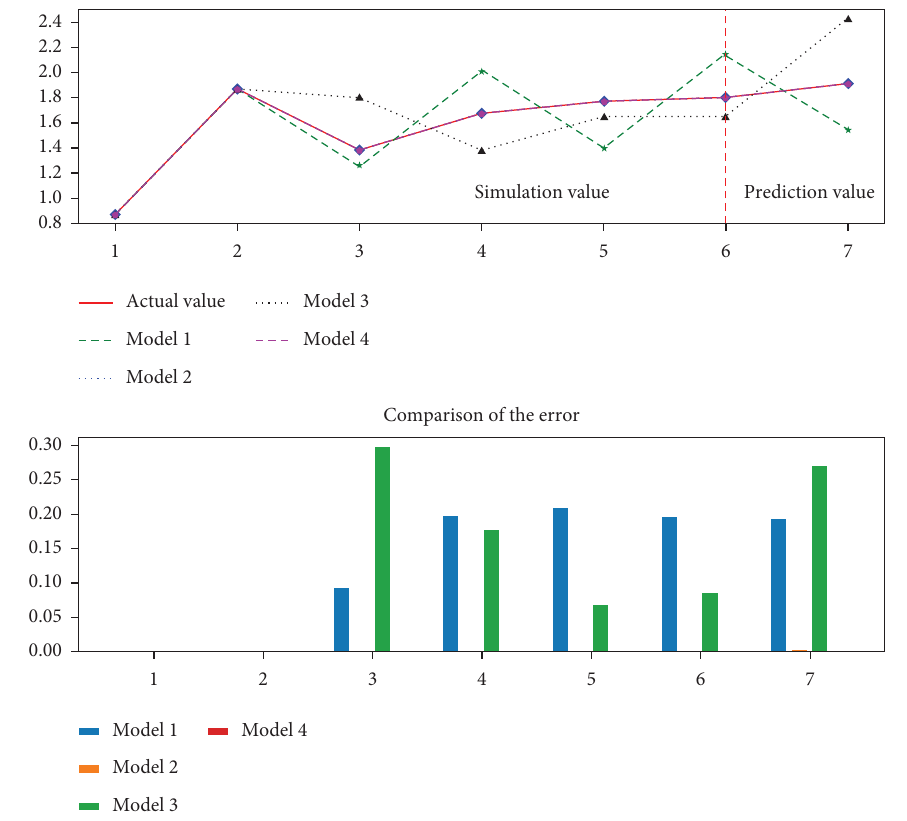
Figure 2: Schematic diagram of the predicted results for stochastic oscillation sequence X